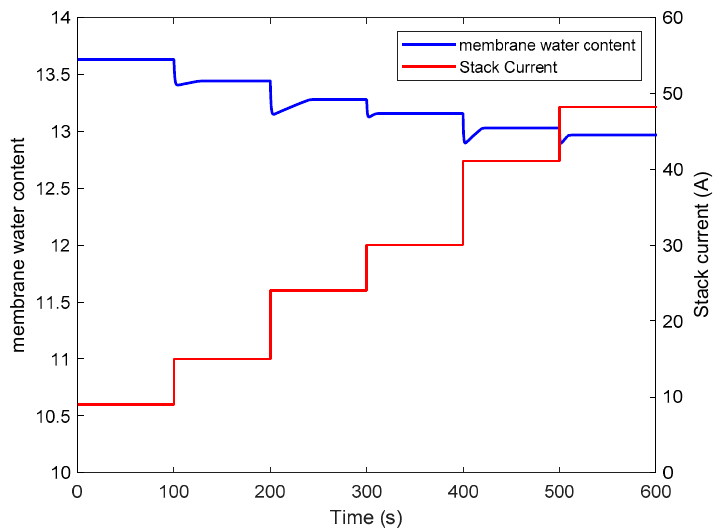
11 of 14 Figure 4. Polarization curve and error analysis